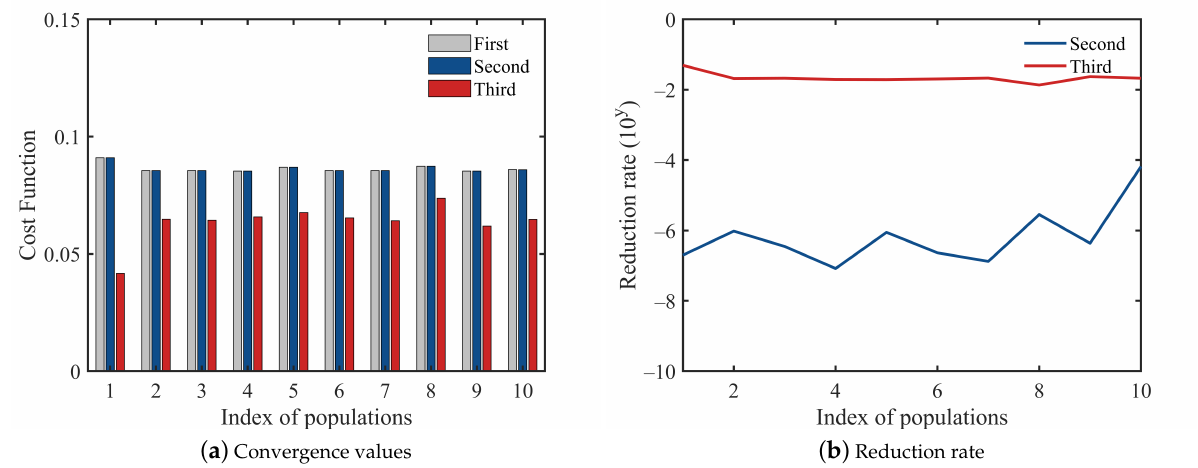
Figure 6. Convergence values of various populations in a three-level optimization